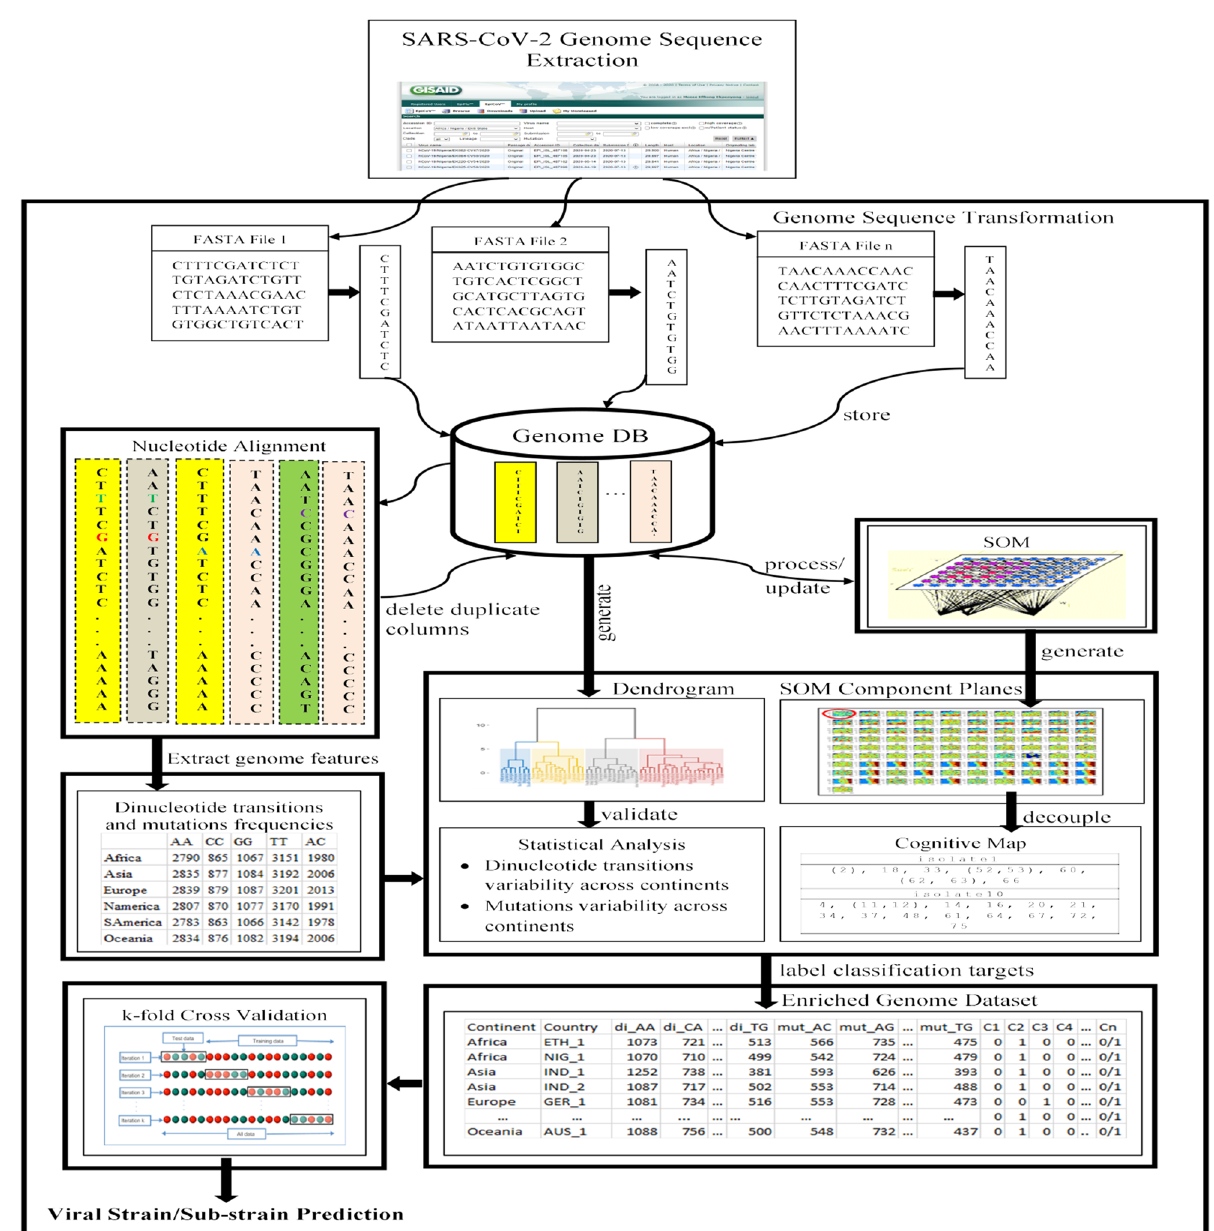
Figure 1. Workflow describing the proposed hybrid approach. The workflow begins with the excavation of FASTA files of human SARS-CoV-2 genome sequences from GISAID. These files were stripped and processed into a genome database (DB) as multiple columns of nucleotide sequence. AI/ML techniques were then applied to extract knowledge from the genome datasets as follows: Using ML techniques, compute dis(similarities) scores between the various pairs of genome sequences and obtain a genomic tree of highly dis(similar) isolates grouped in the form of a dendrogram/phylogenetic tree. Determine the optimal number of natural clusters—to provide additional knowledge for supervised learning. Separate the viral sub-strains using SOM component planes—for possible transmission pathway/pattern visualization. Perform nucleotide alignment of the entire genome sequences (owing to varying sequence lengths of the different genome isolates, a cutoff at the last nucleotide of the genome isolates or the reference genome serves as the maximum pair for comparison), remove duplicate columns while imposing a similarity threshold–to yield unique genome sequences. Extract genome features by computing dinucleotide transitions and mutation frequencies. Generate cognitive map–for intelligent sub-strains prediction. Label classification targets of extracted features using derived SOM clusters and cognitive map. Learn and predict new/emerging sub-strains using ANN with k-fold validation